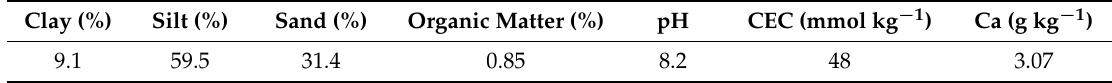
Table 1. Soil characteristics (CEC: cation exchange